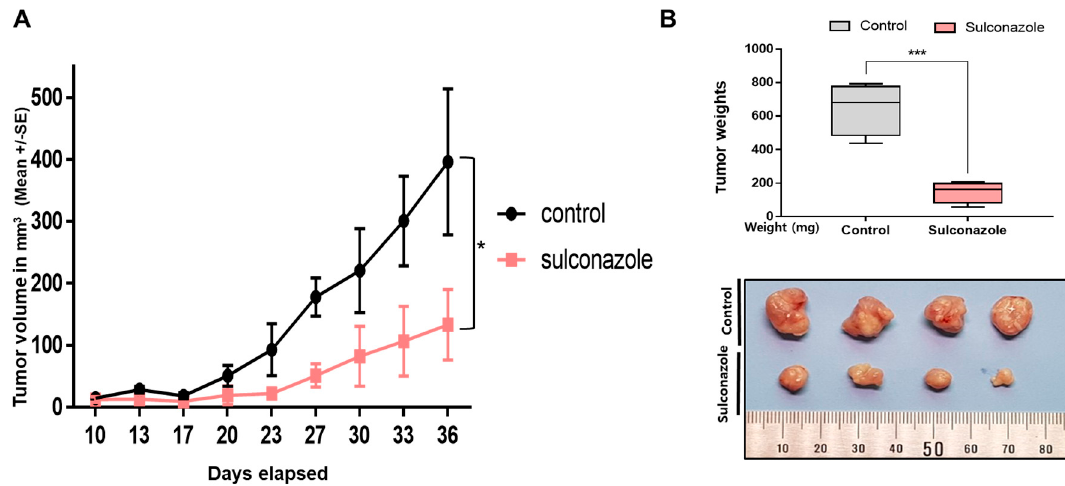
Figure 2. Effect of sulconazole on in vivo tumor growth. ( A ) NOD-SCID nude mice were inoculated with MDA-MB-231 cells and treated with sulconazole or vehicle. The dose of drug used was 10 mg/kg once a week. Tumor volume was measured at the indicated time points using a caliper and calculated as (width 2 × length)/2 and are reported (Mean ± SE). ( B ) The effect of sulconazole on tumor weights was evaluated. Tumor weights were assayed after sacrifice. Photographs were taken of isolated tumors from control or sulconazole-treated mice. * p < 0.05 and *** p < 0.05 vs. the control.